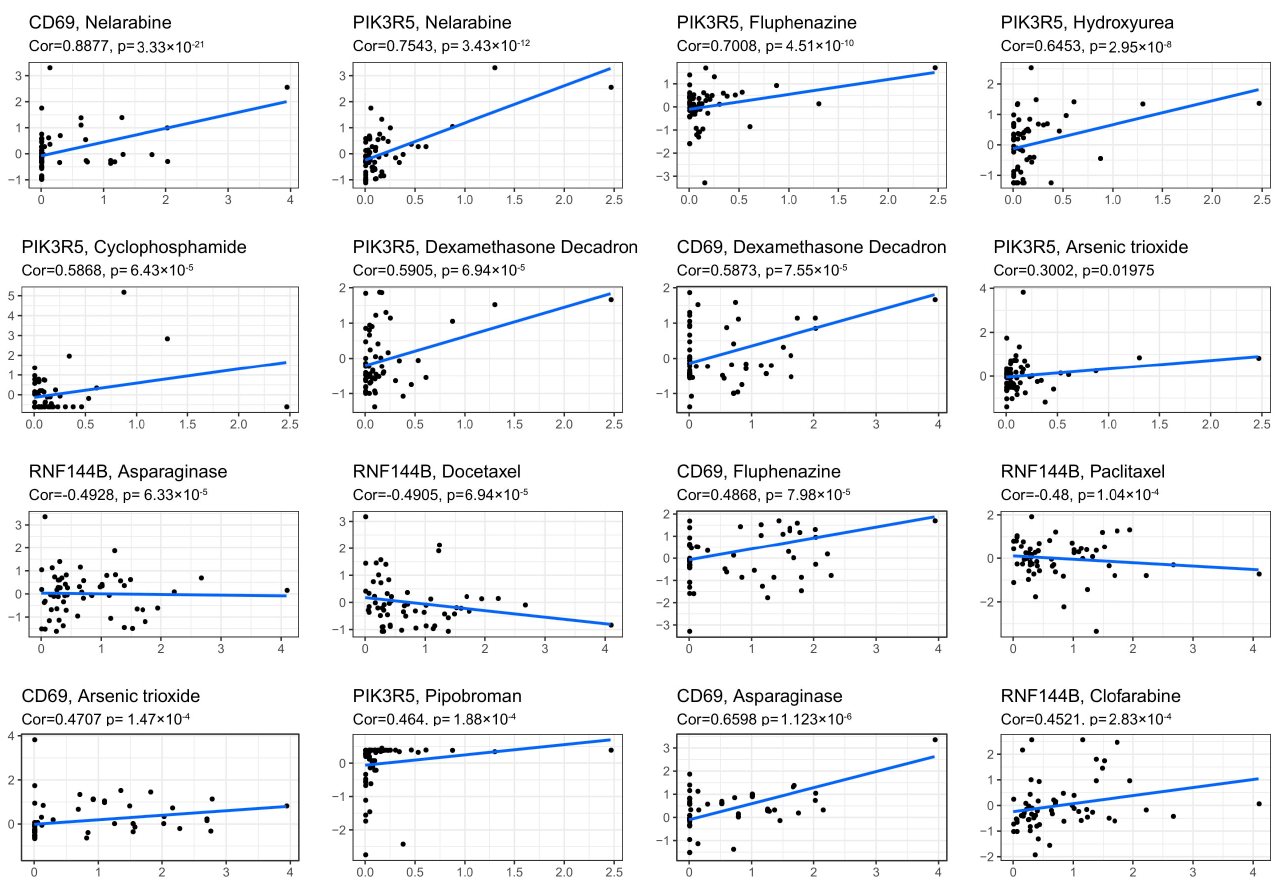
Figure 8. Scatter plot showing the association of levels of prognostic genes with sensitivity to drugs.